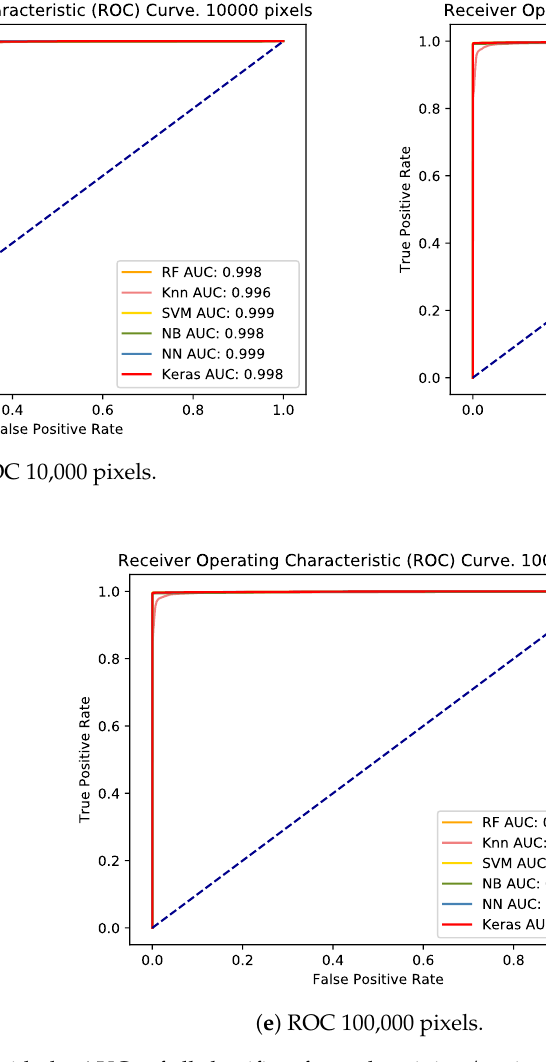
Figure 2. ROC curves with the AUCs of all classifiers for each training/testing data set from 1000 ( a ) to 100,000 ( e )